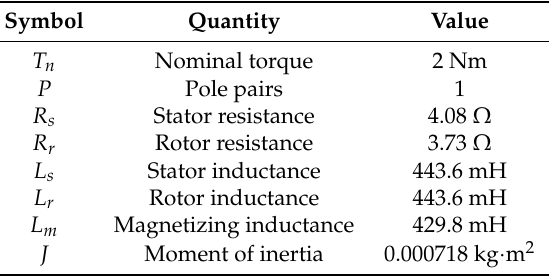
Figure 5. Experimental setup ( a ) schematic ( b ) photograph. Table 2. The parameters of